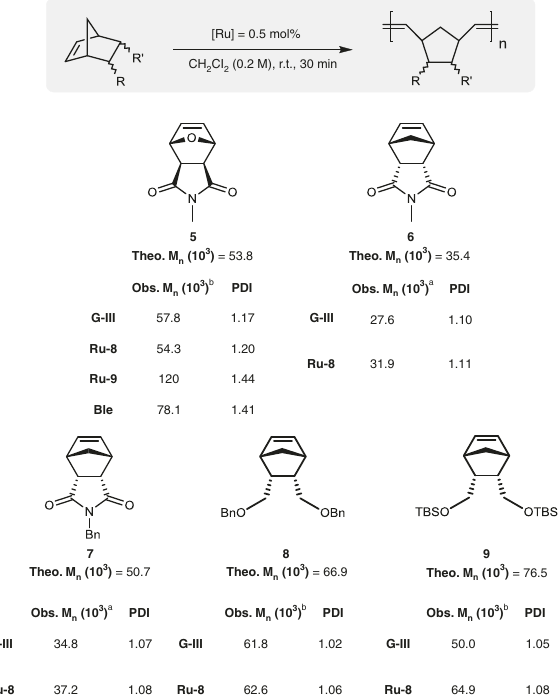
Fig. 4 ROMPs of strained monomers. After quenching with ethyl vinyl ether, the polymer was isolated by precipitation in methanol. a Determined by GPC in tetrahydrofuran (THF) relative to a polystyrene standard. b Determined by GPC in N , N -dimethylformamide (DMF) relative to a polystyrene standard. c Theoretical M n was calculated by assuming quantitative conversion. d Bn = Benzyl; TBS = tert -